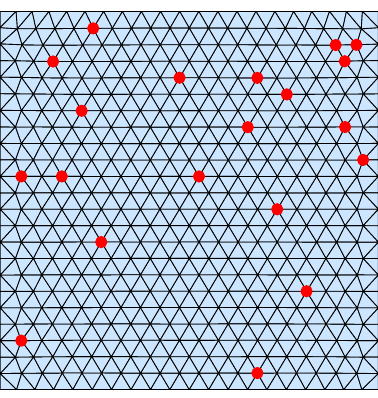
Figure 1. Mesh on Ω . The red points show the locations of